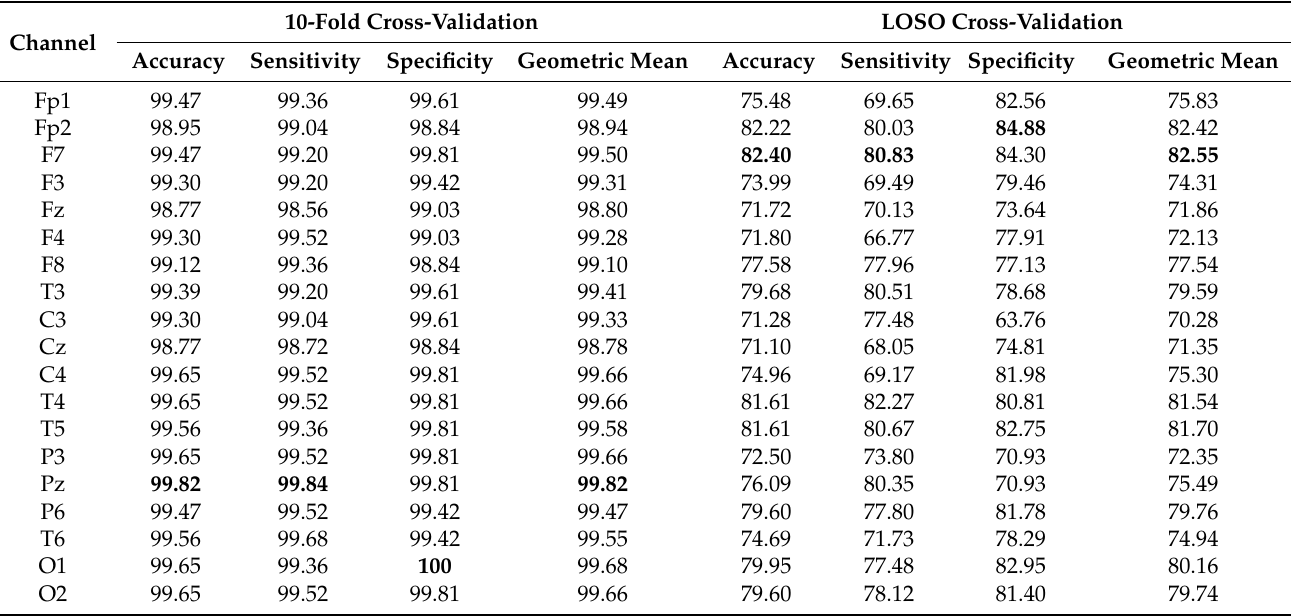
Table 6. The 10-fold cross-validation and LOSO cross-validation results (%) of the CGP17Pat-based model. 10-Fold Cross-Validation Channel